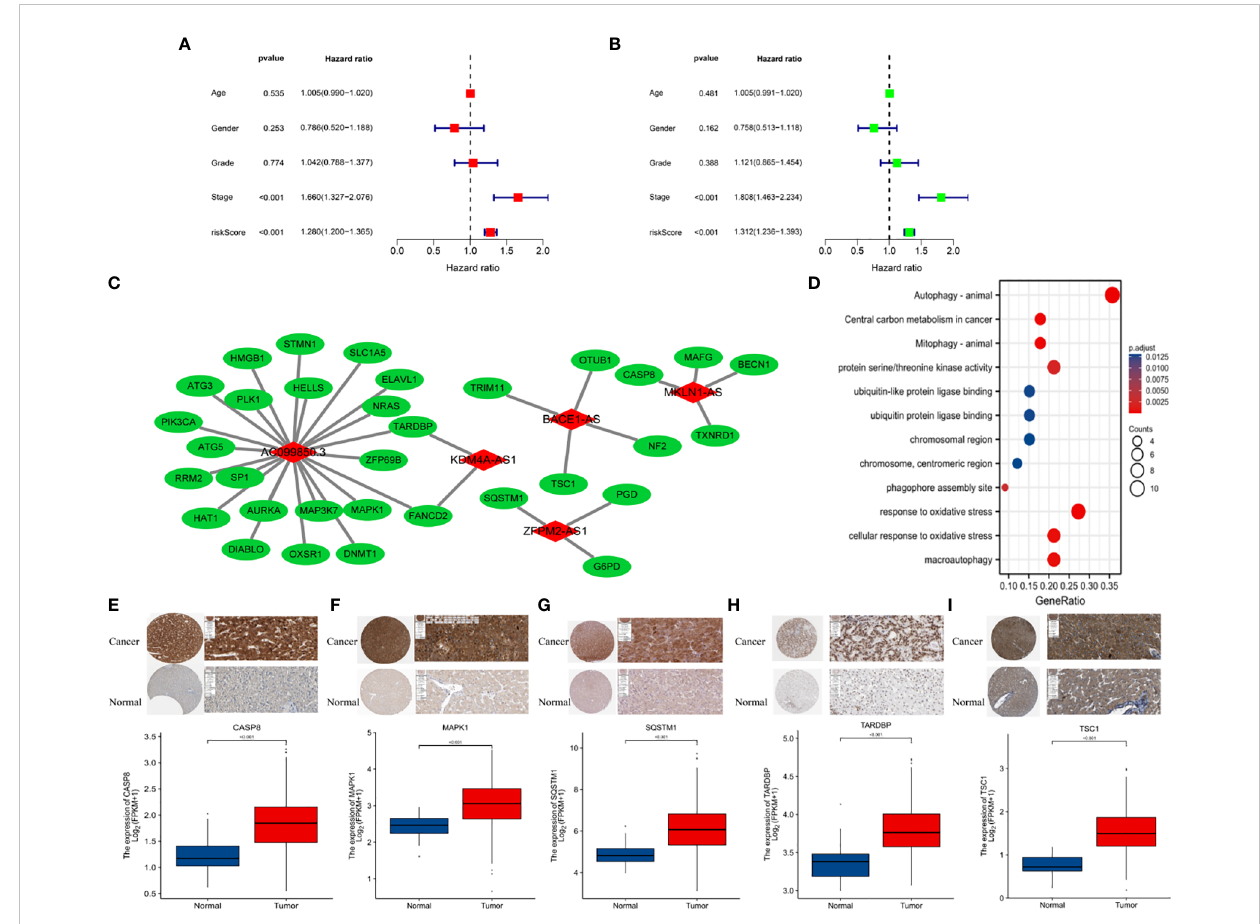
FIGURE 3 (A) Multivariate and (B) univariate Cox regression analyses for age, gender, grade, stage, and risk score. (C) Protein-protein interactions. (D) GO enrichment analysis offerroptosis- and necroptosis-related lncRNAs (F-NLRs). (E) Comparison of CASP8 TARDBP in TCGA-LIHC tumor and normal liver tissue. (F) Comparison of MAPK1 in TCGA-LIHC tumor and normal liver tissue. (G) Comparison of SQSTM1 in TCGA-LIHC tumor and normal liver